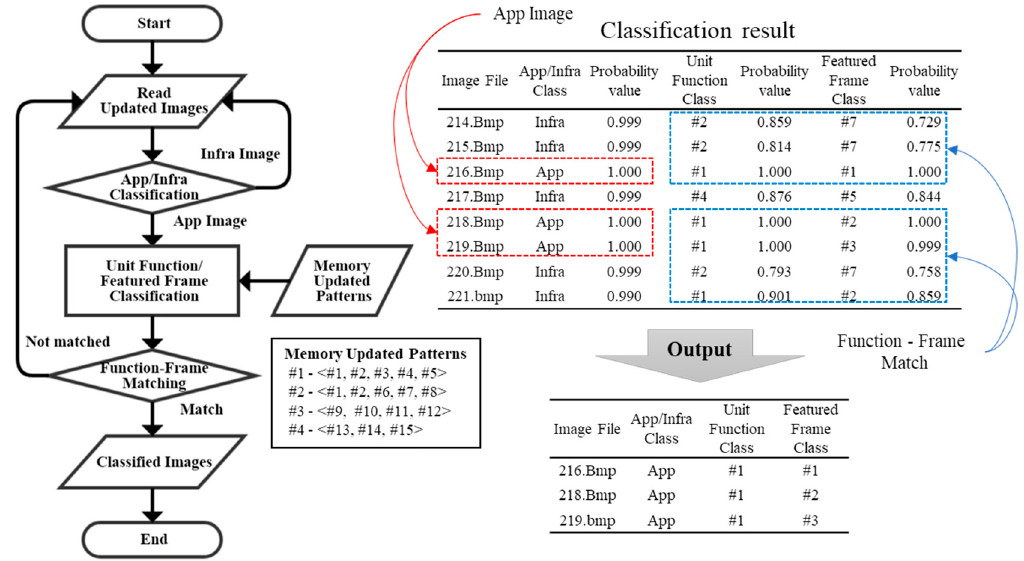
Figure 9. Flowchart of classification of updated features.